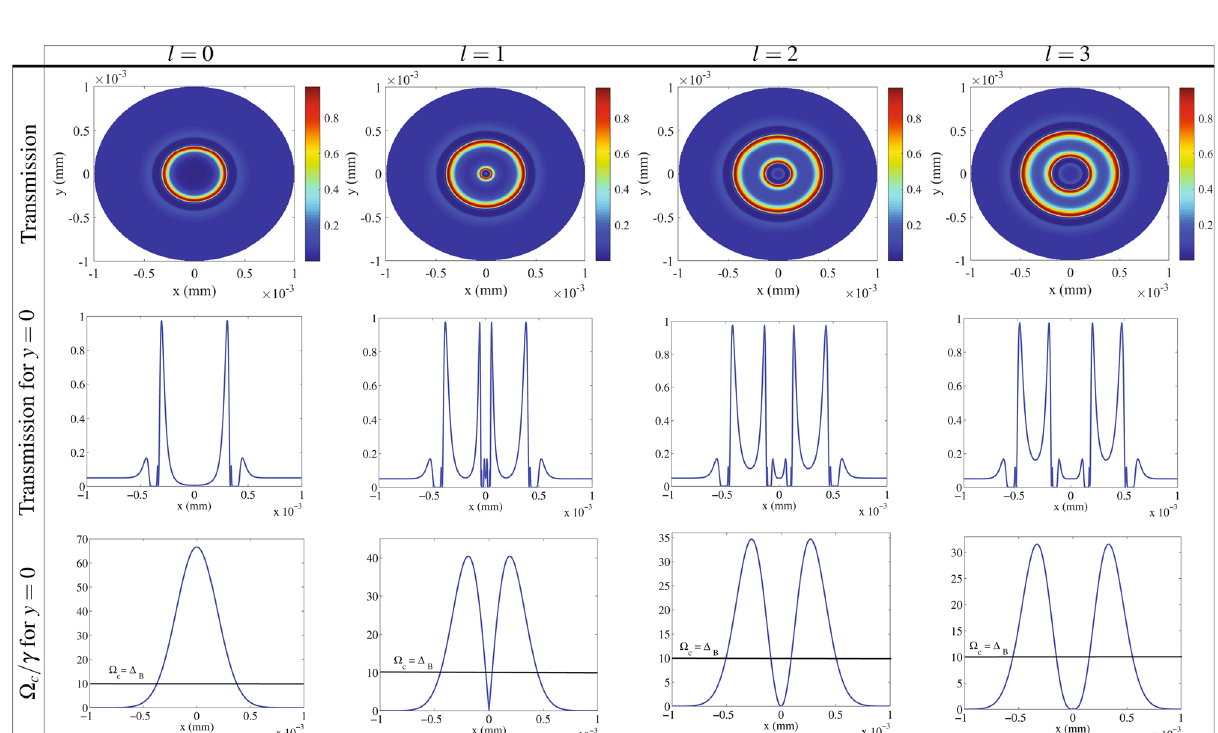
Figure 4. The y -polarized intensity distribution of VBs related to the Fig. 2 as a function of x and y (first row), 0 (second row) and the evolution of the Rabi frequency of the LG control the perspective of transmission in y = 0 (third row). The used parameters are those used in Fig. field for y =